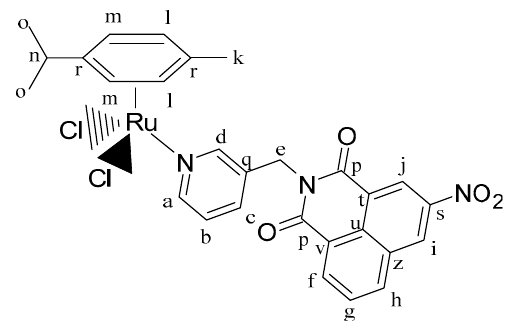
Figure 13 Structure of complex IC2. Figure 13. Structure of complex [( η 6-p-cym)Ru(L2)Cl2] (IC2) .